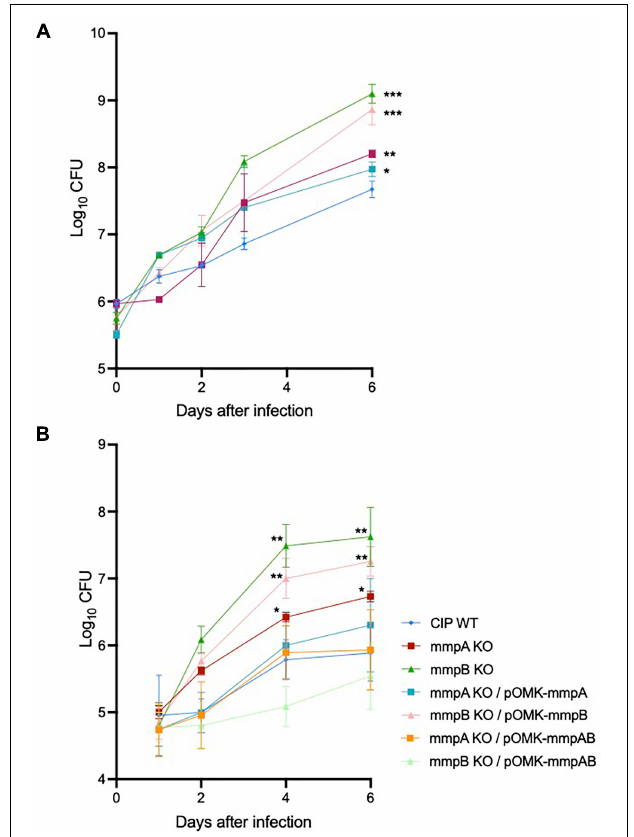
FIGURE 6 | Increased intracellular replication of the porin mutants in SCID and GMCSF knock-out mouse bone marrow-derived macrophages. (A) Intracellular growth of the WT and mutant strains in SCID BMDM. BMDM were infected with Mmas strains at a MOI of 1:1. Viable intracellular bacteria were determined by CFU counting after 2 h of infection or at 1, 2, 3 and 6 days after infection. Values shown are the mean ± SEM from three infected macrophage monolayers. (B) Intracellular growth of the WT, mutant and complemented mutant strains in GMCSF BMDM. BMDM were infected with Mmas strains at a MOI of 1:1. Viable intracellular bacteria were determined by CFU counting after 2 h of infection or at 1, 2, 4, and 6 days after infection. Values shown are the mean ± SEM from three infected macrophage monolayers. Asterisks denote statistical differences between the growth of the knock-out mutants (or the mmpB KO complemented with mmpB only) and the WT parent strain pursuant to the Student’s t -test (* P < 0.05; ** P < 0.01; *** P < 0.005).